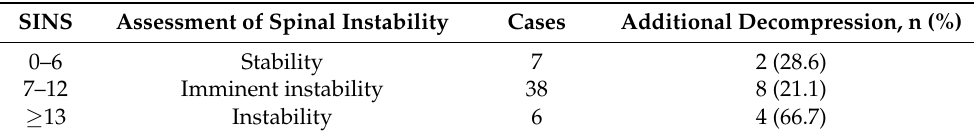
Table 3. Details of preoperative SINS evaluation and additional laminectomy.